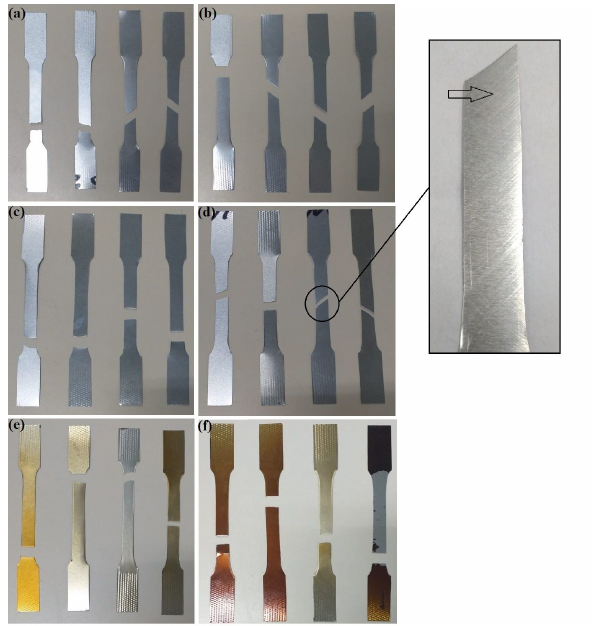
Figure 7. AA 5182 aluminum alloy samples heated for a period of 10 min. Fracture of samples at different temperatures: a) 50 ºC, b) 100 °C, c) 150, d) 200°C, e) 250 °C, and f) 300°C.